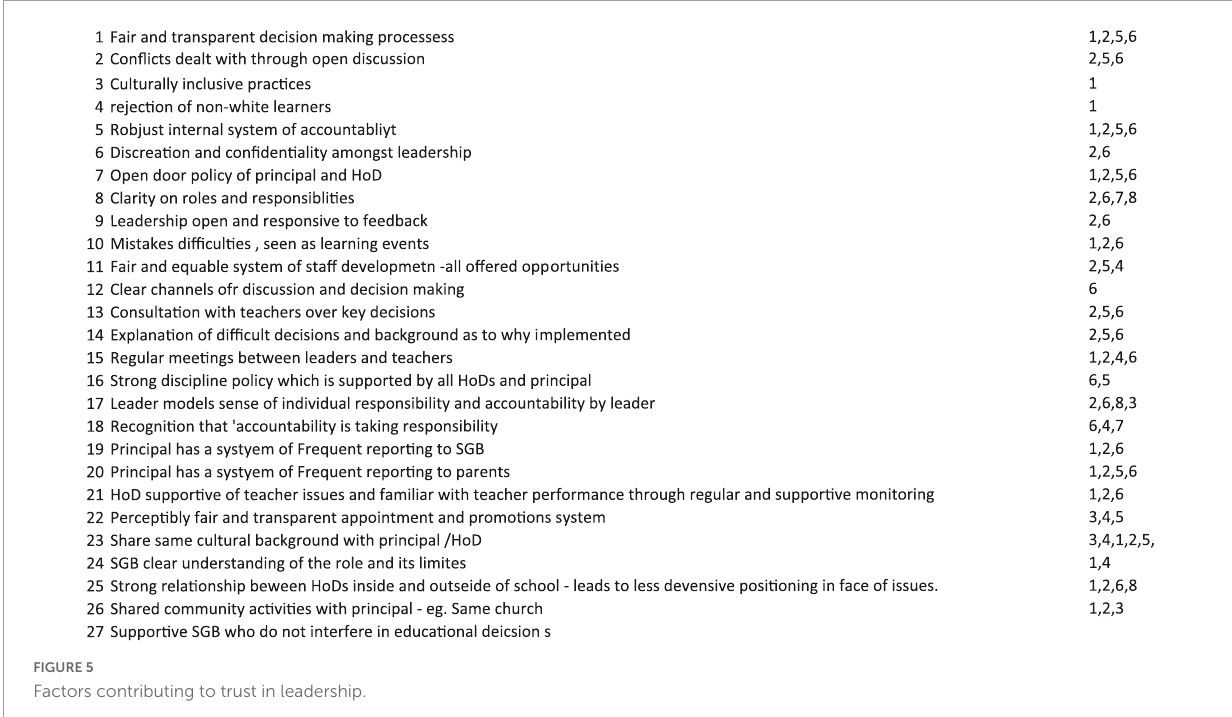
FIGURE5 Factors contributing to trust in